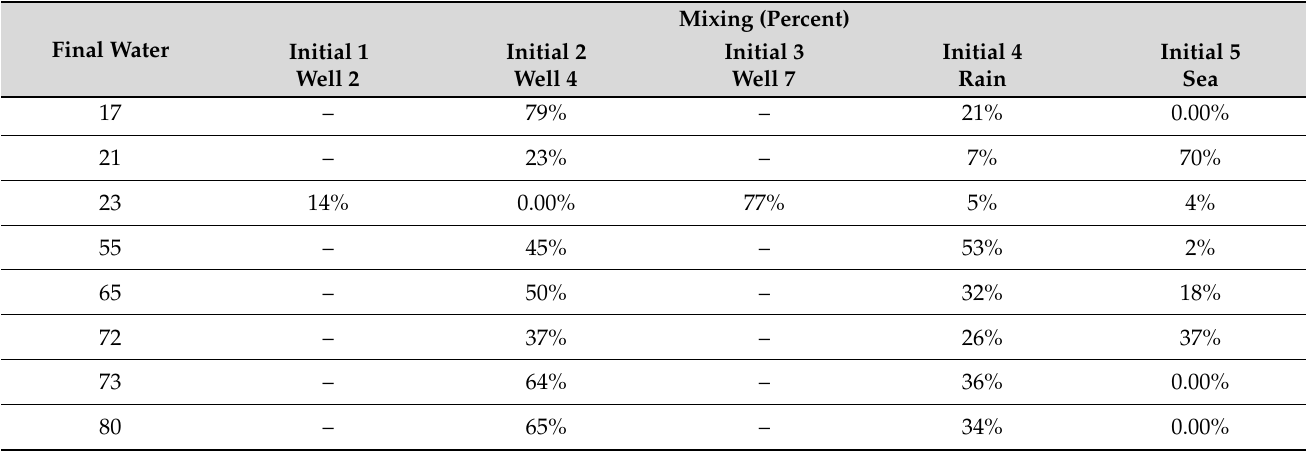
Table 4. Netpath mixing ratio calculations in some selected groundwater